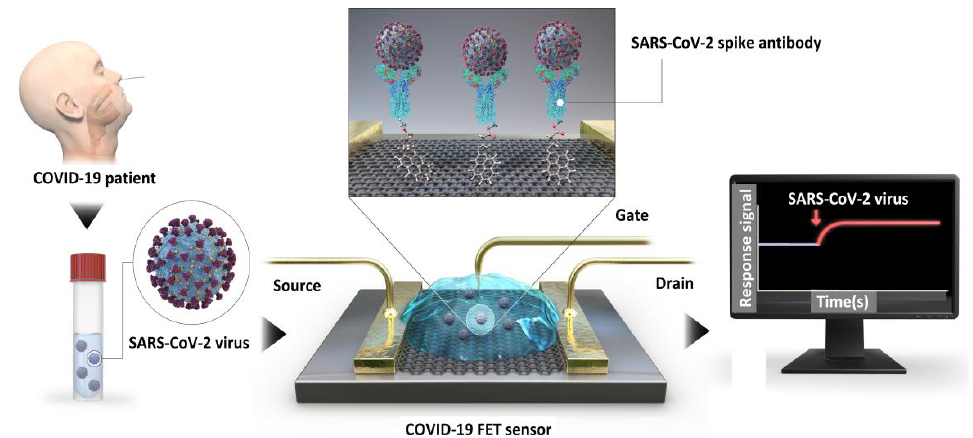
Figure 4. Schematic sketch of the operational procedure of graphene based COVID-19 FET sensor for detection of SARS-CoV-2 spike antibody. Reproduced from [51] with permissions granted for the duration of the World Health Organization (WHO) declaration of COVID-19 as a global pandemic.